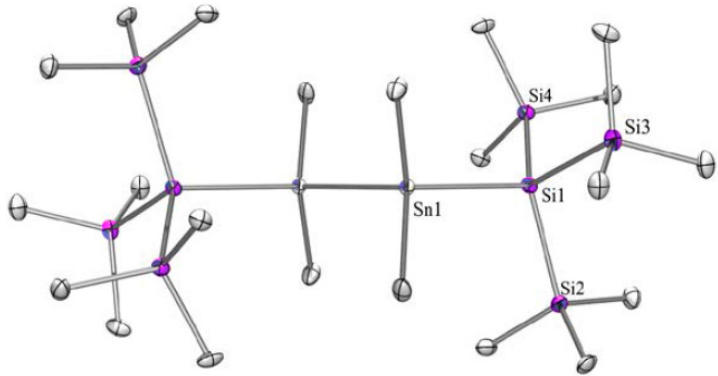
Figure 2. Molecular structure of 5 (thermal ellipsoid plot drawn at the 30% probability level). Non- labeled atoms are generated by symmetry operations. All hydrogen atoms are not shown for clarity (bond lengths in Å, angles in °). Sn(1)–C(11) 2.182(9), Sn(1)–Si(1) 2.579(3), Sn(1)–Sn(1A) 2.7950(13), Si(1)–Si(2) 2.344(3), Si(2)–C(1) 1.878(9), Si(1)–Sn(1)–Sn(1A) 116.47(6).